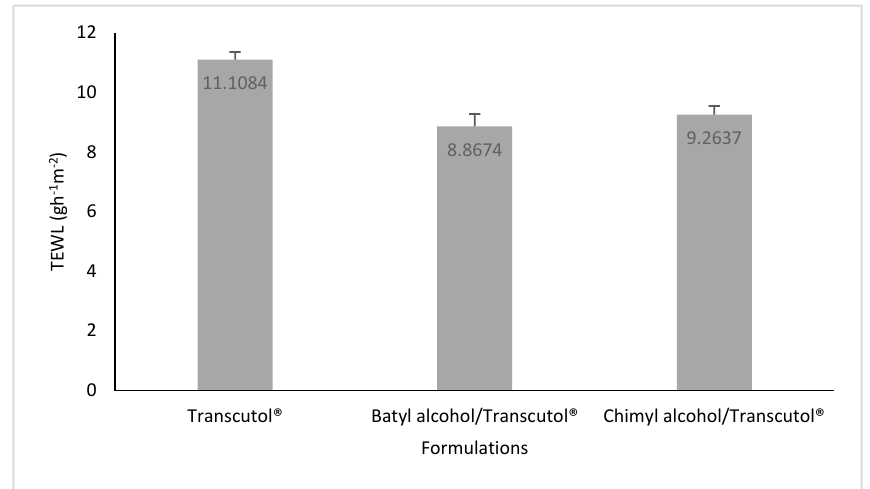
Figure 5. TEWL values for skin treated with Transcutol ® , batyl alcohol/Transcutol ® , and chimyl alcohol/Transcutol ® . * p < 0.05 for Transcutol ® vs. batyl and chimyl alcohols.